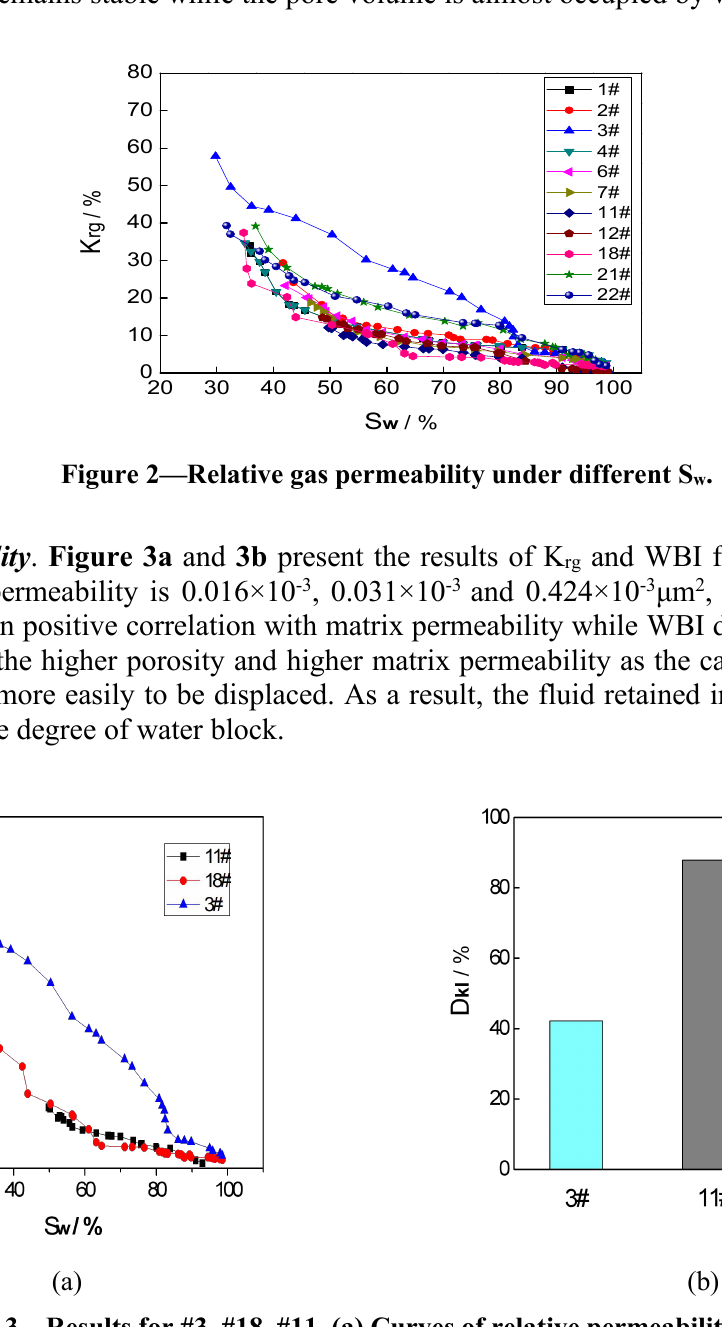
Figure 3—Results for #3, #18, #11. (a) Curves of relative permeability. (b)